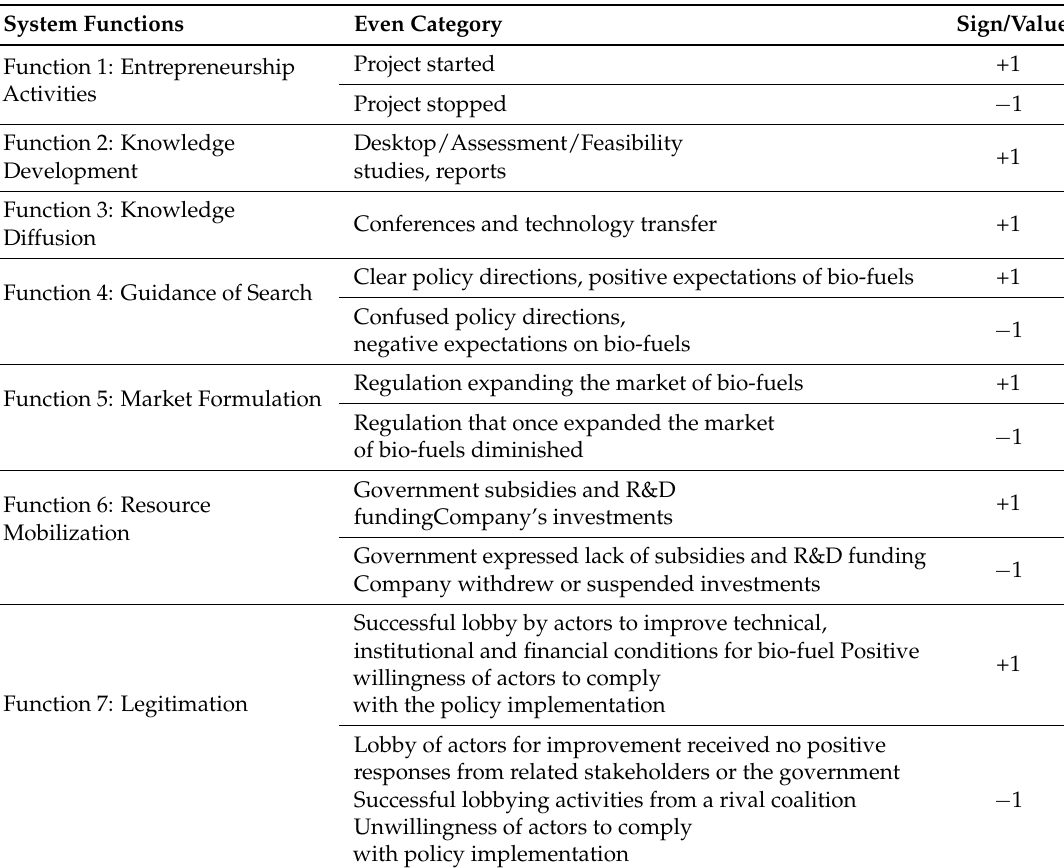
Table 3. Operation of system